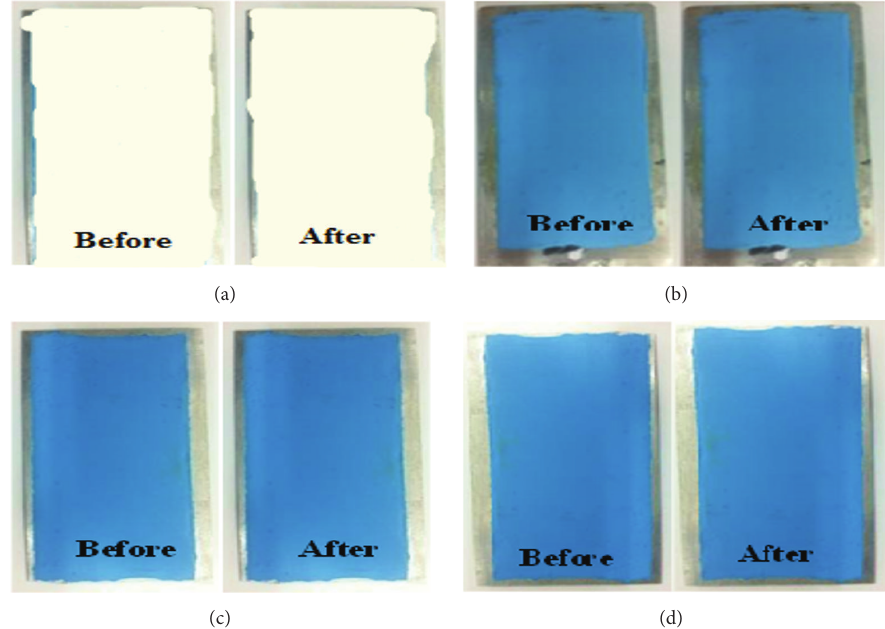
Figure 8: Samples of PU (a), CuPc(1%)/PU (b), CuPc(15%)/PU (c), and CuPc(30%)/PU (d) before and after being exposed to UV.